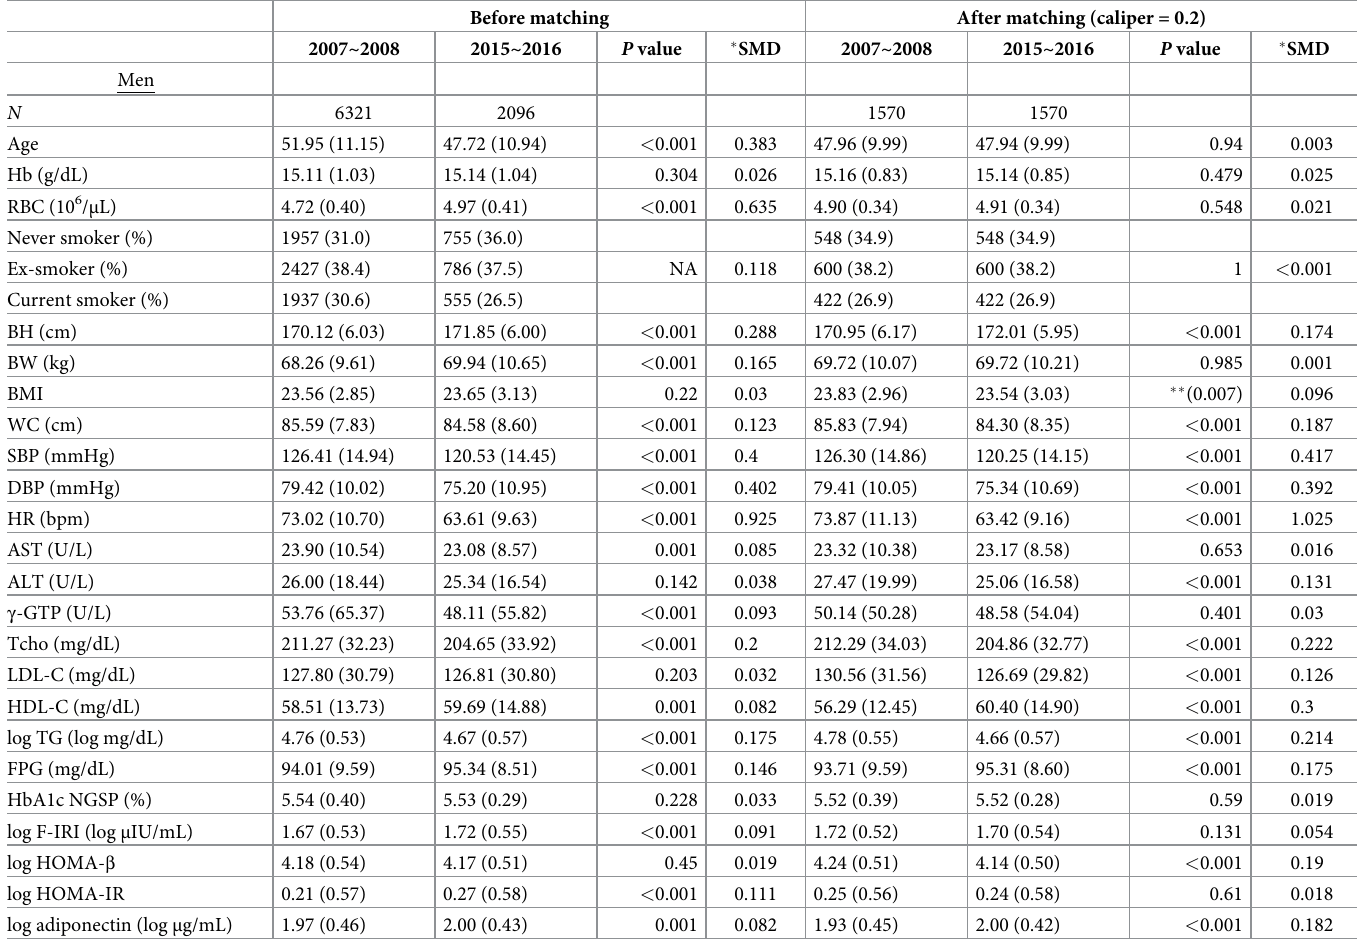
Table 1. Clinical characteristics and biochemical parameters of men without diabetes mellitus before and after pair-matching. Before matching After matching (caliper =